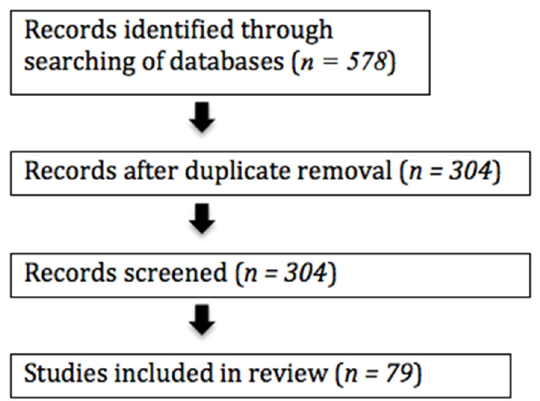
Figure 1. Flowchart of study selection process.